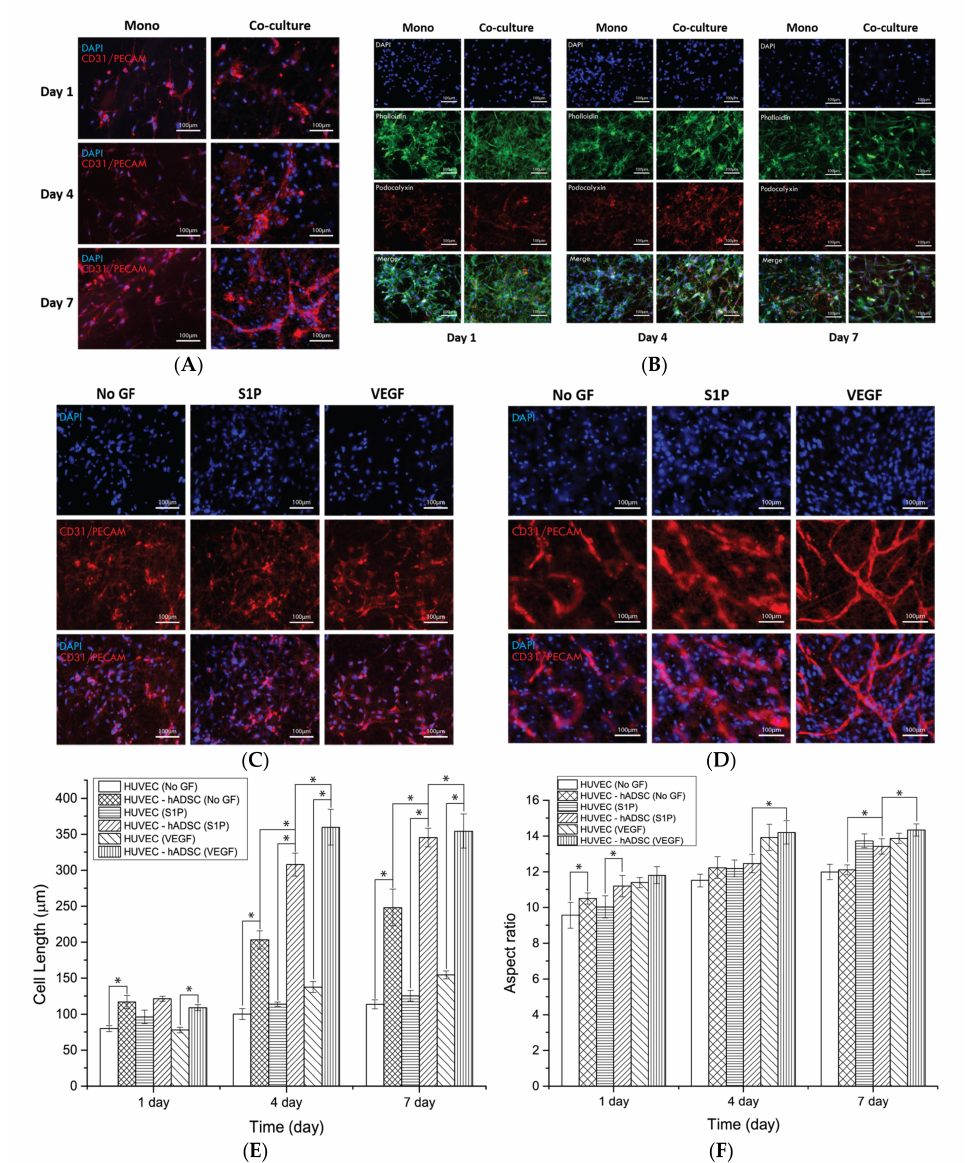
Figure 5. Blood vessel formation of HUVECs under mono- and co-culture on the PCL/gelatin nanofibrous scaffolds with immunofluorescence staining of blood vessel phenotypic markers. ( A , B ) Immunofluorescence images to express endothelial cells markers, ( A ) intercellular junction protein, CD31/PECAM and ( B ) podocalyxin at 1, 4, and 7 days; ( C , D ) Representative immunofluorescent images of CD31/PECAM of HUVECs cultured in ( C ) monoculture system and ( D ) co-culture system to observe HUVECs behavior under different medium conditions on the PCL/gelatin nanofibrous scaffolds after seven days culture; ( E ) Length of HUVECs on the PCL/gelatin nanofibrous scaffolds under several culture conditions; ( F ) Aspect ratio of HUVECs on the PCL/gelatin nanofibrous scaffolds under several culture conditions. One-way ANOVA; Tukey’s post hoc test; * compared to each group; * p <